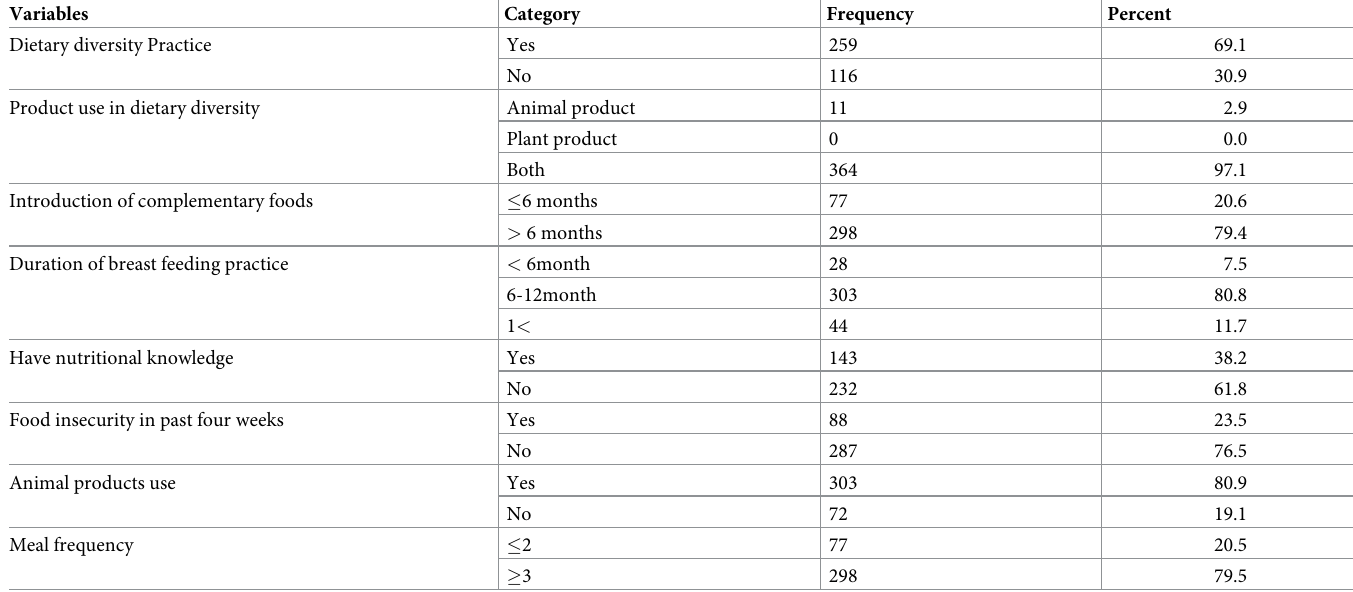
Table 2. Feeding-related characteristics of children.